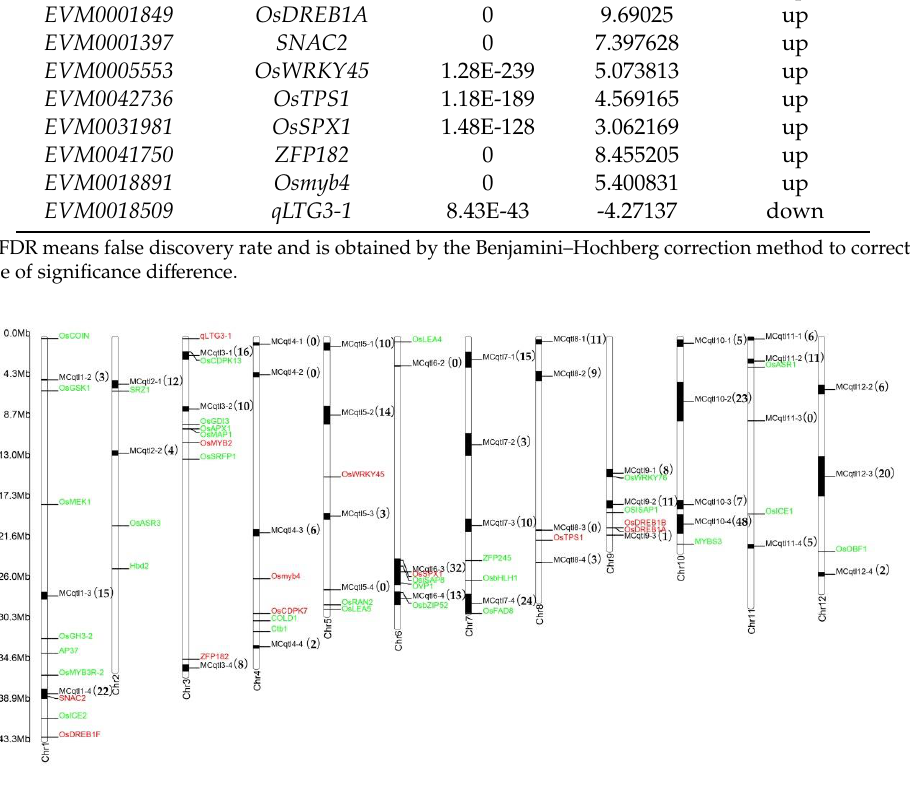
Figure 6. DEGs mapping in Meta-QTLs from Yang et al. (2018). The green genes were cold–stress-related genes that have been cloned previously, but not the DEGs of this study. The red genes were the DEGs in this study and also belong to cold–stress-related genes previously reported. Black boxes in each chromosome (Chr) represent Meta-QTLs (e.g., MCqtl1-2, MCqtl1-3) and the number after Meta-QTL represents the number of our DEGs in this Meta-QTL segment.